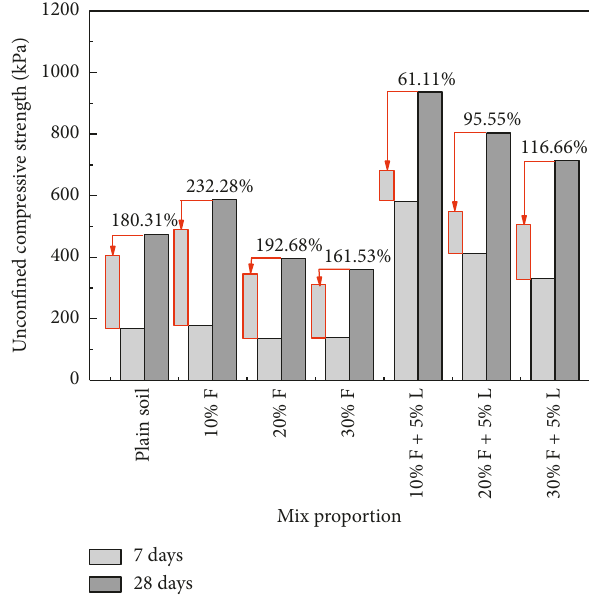
Figure 10: Variation laws of unconfined compressive strength with stabilizing time.